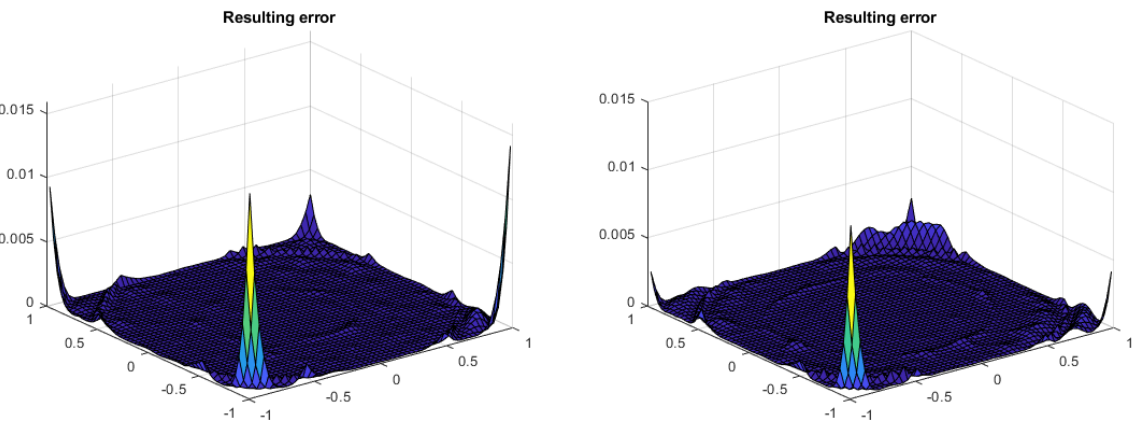
Figure 9. Resulting error on the validation patterns. The dynamic alpha modification on the ( left ) and the mixed dynamic alpha and drop-out on the ( right ).